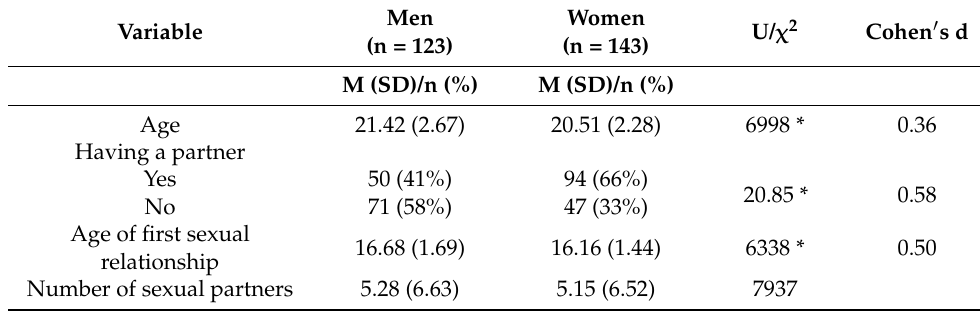
Table 5. Sociodemographic characteristics of the sample from Study